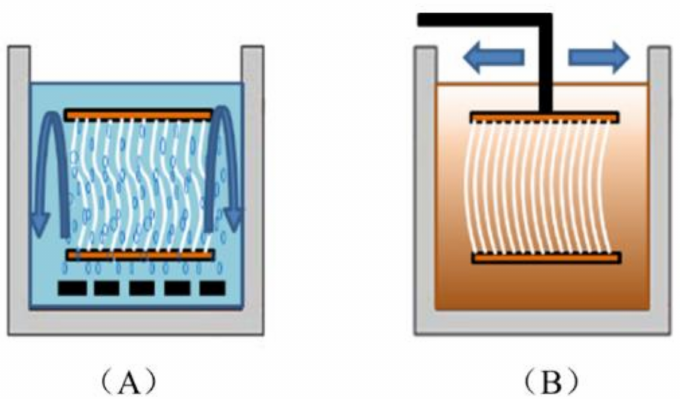
Figure 11. Membrane fouling control mode of ( A ) VMBR and ( B )